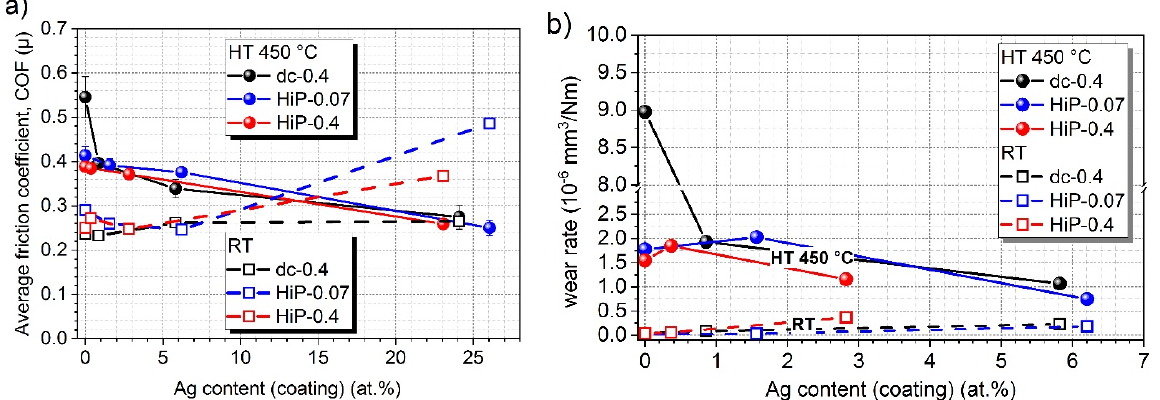
Figure 14. Comparison of the average friction coefficient ( a ) and wear rate ( b ) of MoN-Ag coated steel vs. Ag content studied by pin-on-disc tests with Al 2 O 3 counterpart (30,000 rotations) at RT (dashed lines) and HT (compact